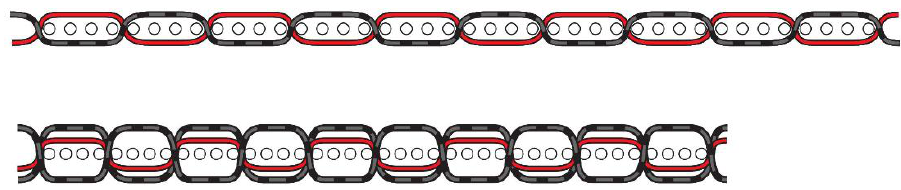
Figure 8. Model for the change in structural properties of fabrics with introduced PBT-containing yarns in the weft after thermal treatment (red lines show PBT-containing yarns).